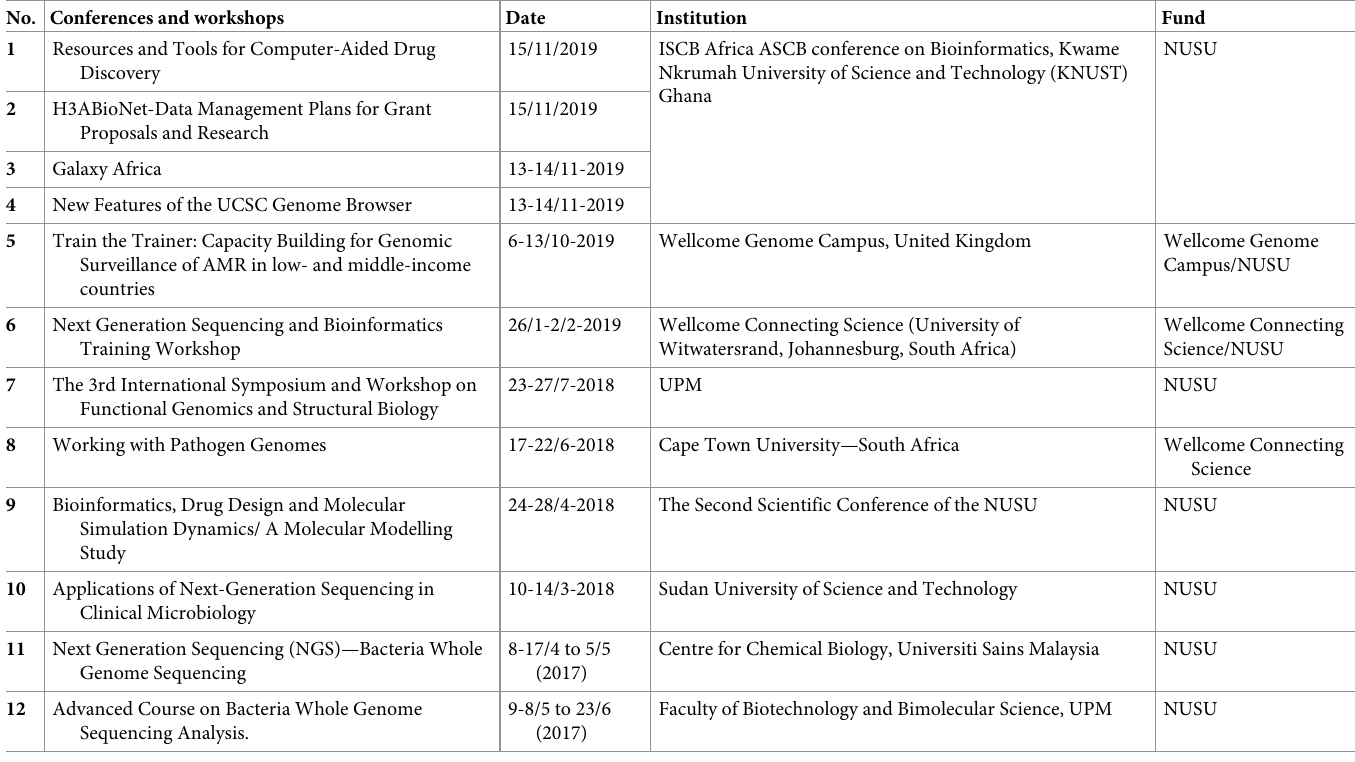
Table 2. International workshops and conferences in which NUBRI staff have